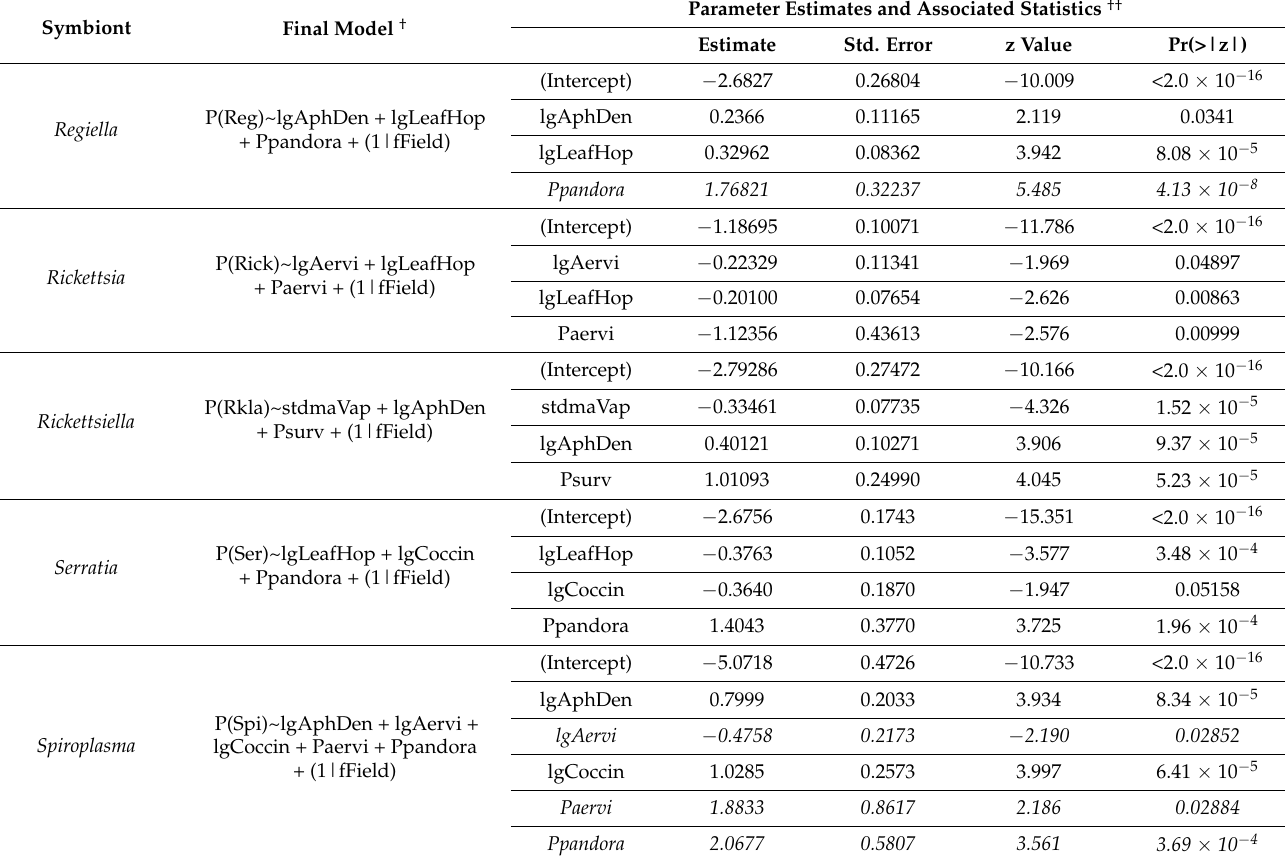
Table 2. Generalized linear mixed models identifying environmental correlates of symbiont frequencies across the growing season of 2012 (simultaneous